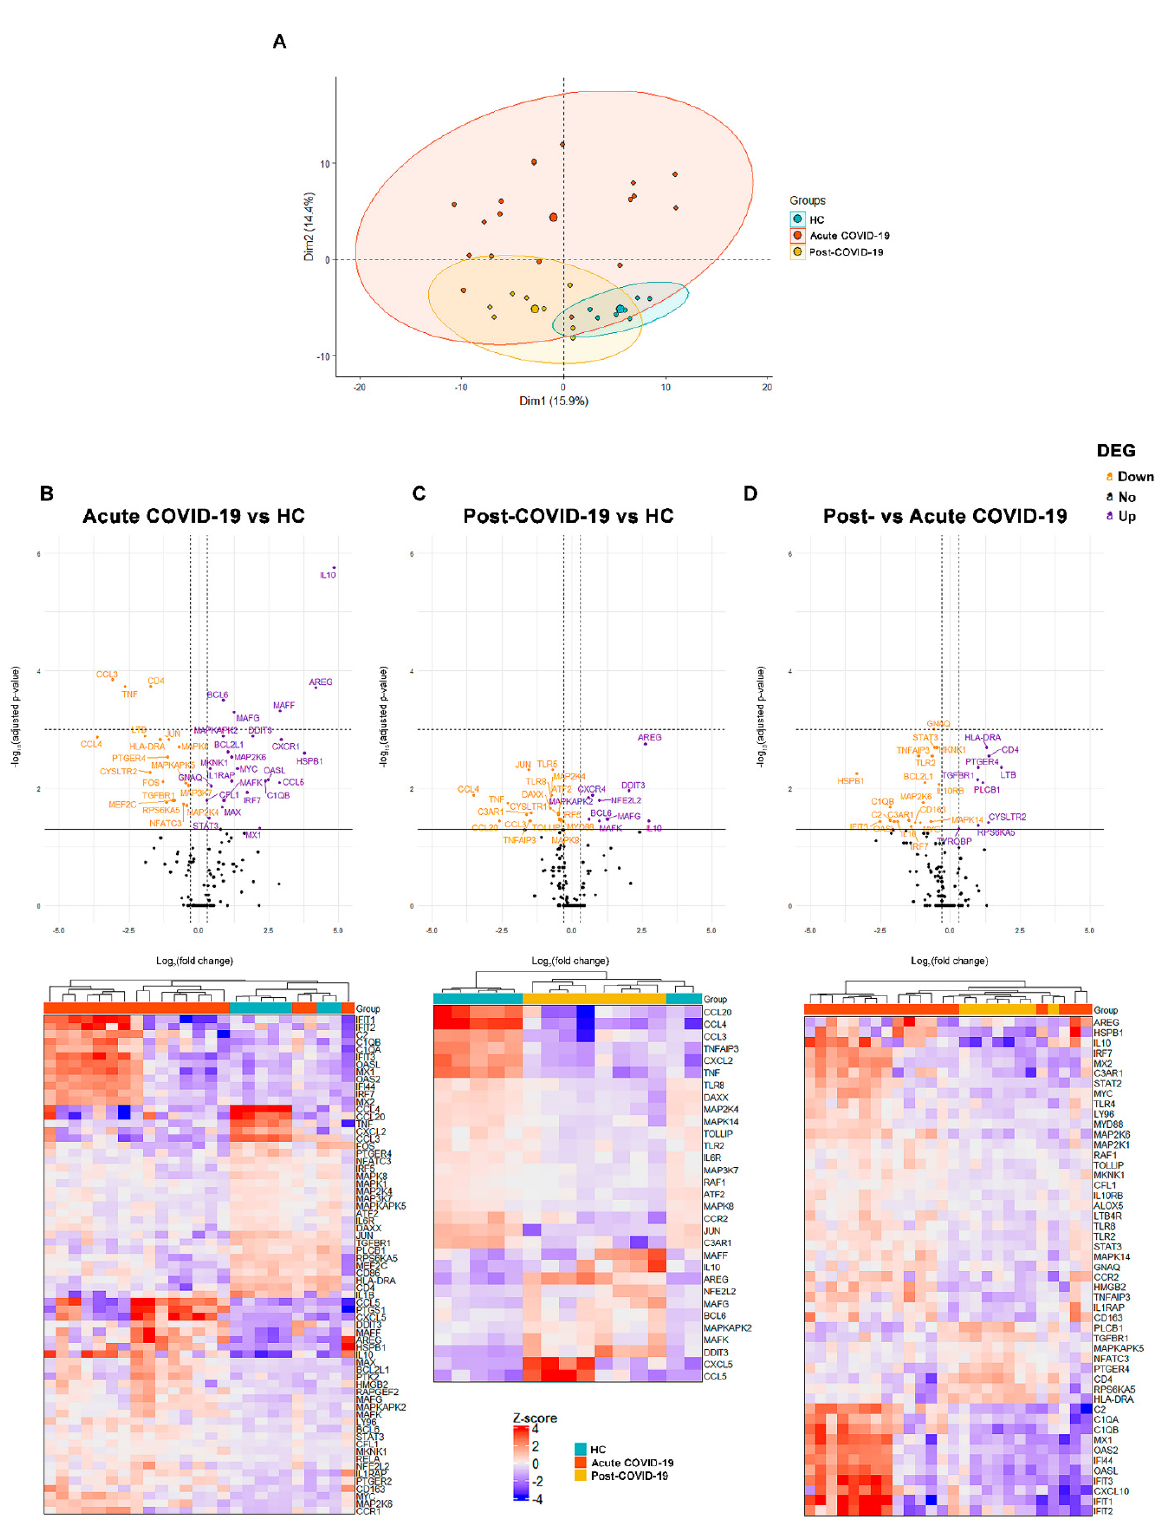
Figure 3. The transcriptomic profiling of circulating monocytes reveals an anti-inflammatory program in early acute COVID-19 still detectable in post-COVID-19 subjects. ( A ) PCA based on 255 analyzed genes clearly separated monocytes from HC, acute and post-COVID-19 patients. DEG of monocytes from ( B ) HC and acute COVID19, ( C ) HC and post-COVID19, ( D ) acute and post-COVID19. In ( B – D ), top panels depict volcano plots showing the genes with significant differences, horizontal solid line indicates a p -value < 0.05 and horizontal dashed line indicates a p -value < 0.001; vertical lines indicate log2 fold change < − 0.6 and >0.6; bottom panels depict heatmaps showing the individual expression of significant DEG in each subject.